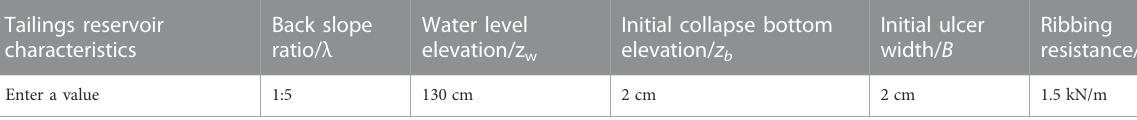
TABLE 1 Tailings reservoir characteristic parameter setting table.